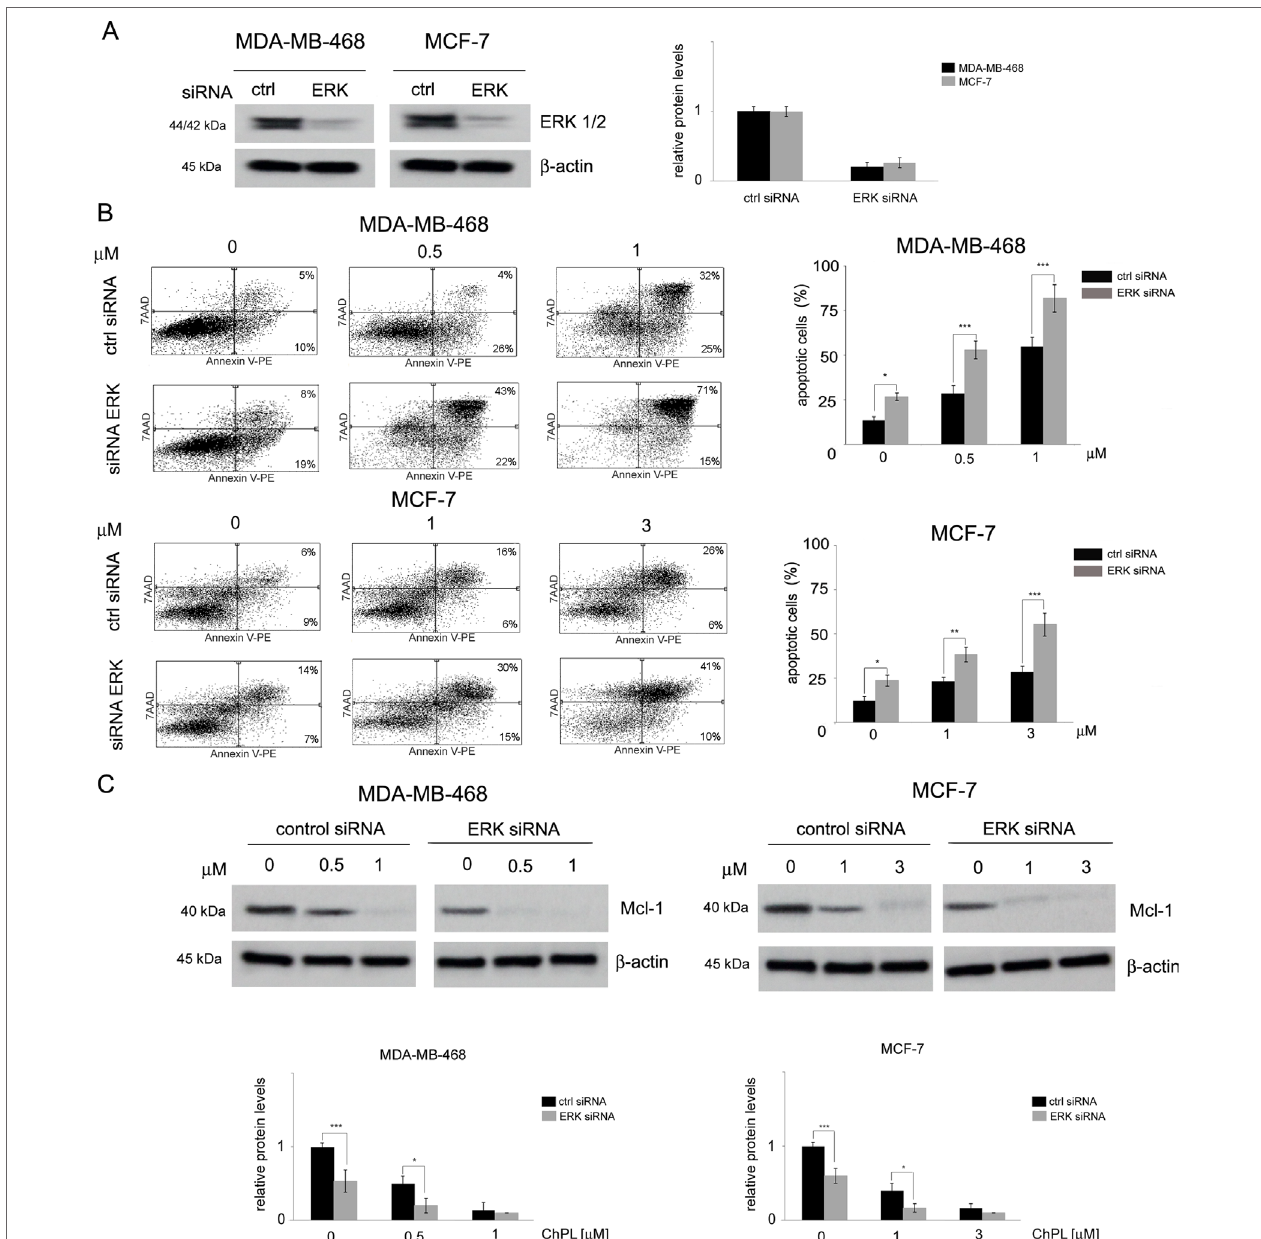
FIGURE 5 | The role of MAPK signaling in 3-chloroplumbagin-mediated ERK inhibition and apoptosis induction. (A) Silencing of ERK1/2 with ERK1/2 siRNA and control siRNA in MDA-MB-468 and MCF-7 cells. Protein levels were determined with Western blot analysis. Densitometric analysis represents ERK1/2 levels normalized to β –actin levels. (B) Apoptosis induction by ChPL in MDA-MB-468 and MCF-7 cells transfected with ERK siRNA or control siRNA. Apoptosis induction was assessed with flow cytometry after Annexin V-PE staining. (C) Influence of ERK silencing on expression levels of Mcl-1 in MDA-MB-468 and MCF-7 cells treated with ChPL. Mcl-1 levels were assessed with Western blot analysis. Densitometric analysis represents Mcl-1 levels normalized to β -actin levels. Data were analyzed by one-way ANOVA with Tukey’s post hoc tests [ p < 0.05 (*), p < 0.01 (**), p < 0.001 (***), n =